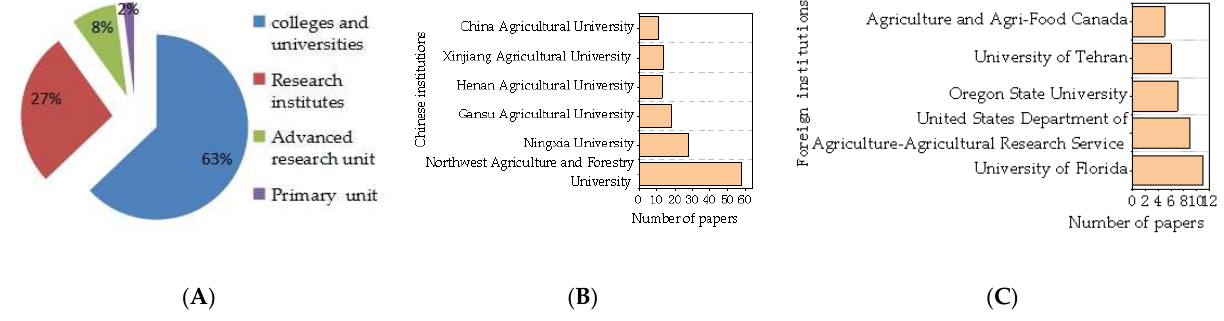
Figure 3. Distribution of research institutions ( A ), ( B ) Chinese institutions and ( C ) foreign institu- tions.